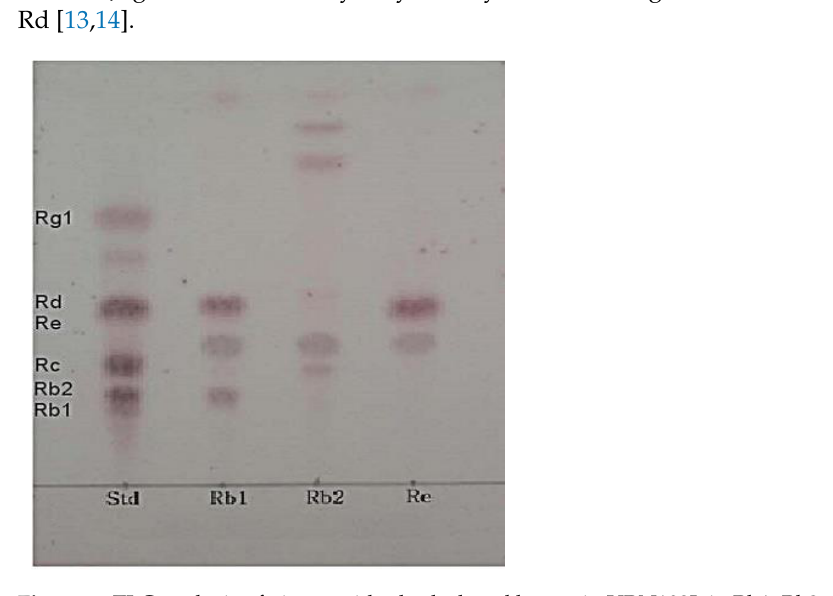
Figure 2. TLC analysis of ginsenosides hydrolyzed by strain URN103L in Rb1, Rb2, and Re for 7 days. Std: standard.